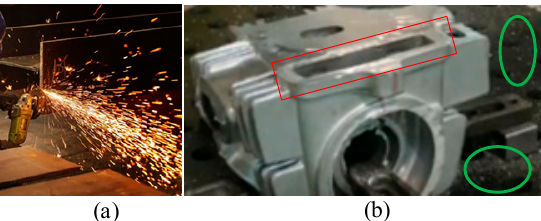
Figure 2. Debris splash scene. ( a ) grinding scene ( b ) grinding effect (thermal debris from sanding of the red part splashes on the green part.)